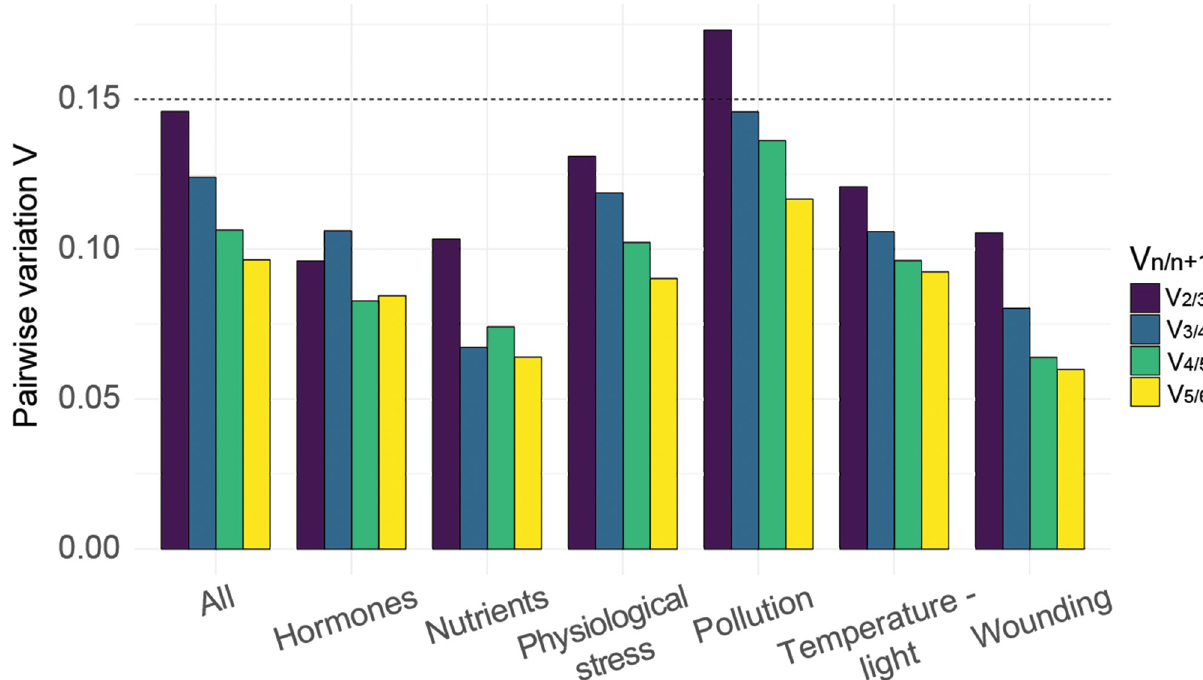
Fig 4. Calculation of optimal number of housekeeping genes. Pairwise variation (V n/n+1 ) was calculated in all tested samples; all (all conditions together), hor (hormones), nutr (nutrients), phy (physiological stress), pol (pollution), t-l (temperature-light), wou (wounding). The V n/n+1 values below the 0.15 threshold (dotted line) indicate that n normalization genes are sufficient.